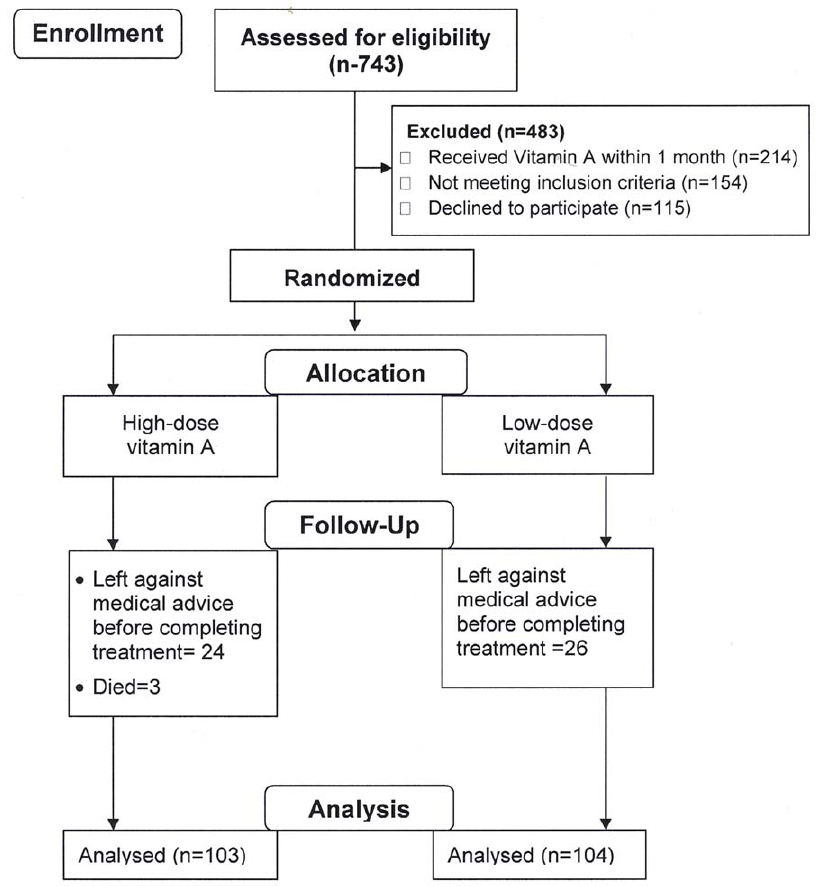
Figure 1. Study profile.